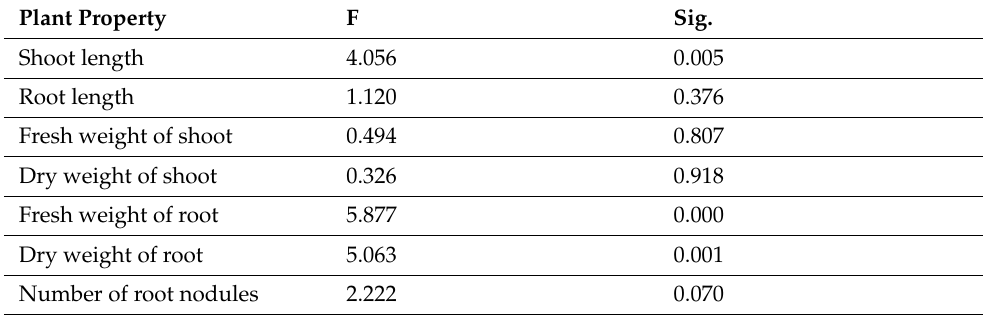
Table 5. One way analysis of variance of plant properties affected by microplastic and